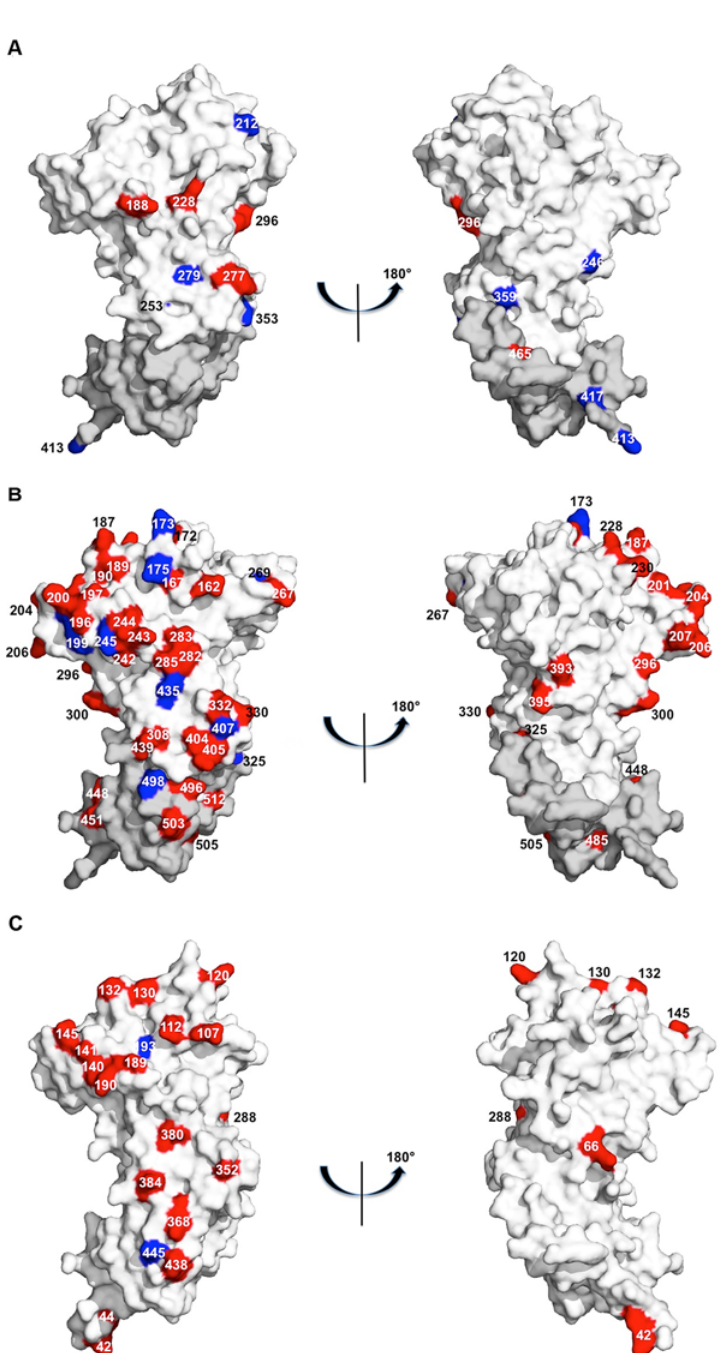
Fig 3. Three-dimensional distribution of polymorphic amino acid residues of PkAMA1, PfAMA1 and PvAMA1. Two views of a surface representation, rotated by 180° with respect to each other, are shown for the crystal structures of (A) PkAMA1 (PDB entry 4UV6), (B) PfAMA1 (PDB entry 2Z8V) and (C) PvAMA1 (PDB entry 1W8L), with each orthologue oriented at equivalent angles. PkAMA1 polymorphisms are from this study, PfAMA1 polymorphisms are from refs [23,24] and PvAMA1 polymorphisms are from ref [25]. Polymorphic residues are labeled and colored in red for high frequency polymorphisms ( > 10%) and in blue for low frequency polymorphisms ( < 10%). Domains 1 and 2 from crystal structures of all three orthologues are shown in white. Domain 3, shown in grey, was modeled for PkAMA1 and PfAMA1 from the crystal structure of PvAMA1 since the crystal structure of this domain has not been determined for these two orthologues. (PkAMA1 Domain 3 polymorphic residues 411 and 481 are not shown as these are disordered and thus not visible in the PvAMA1